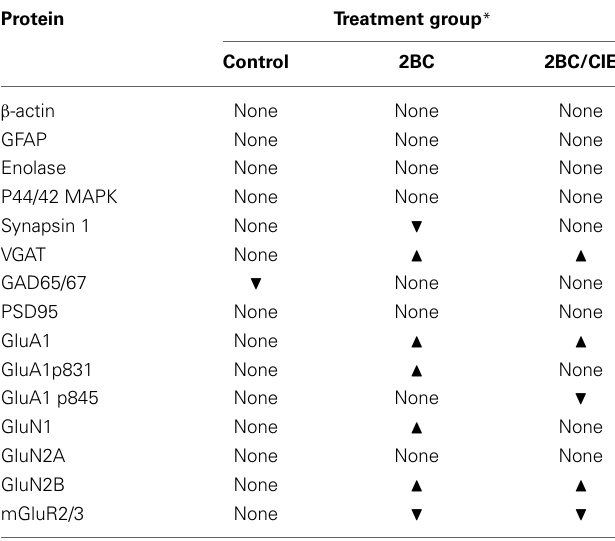
Table 1 | CCL2 and CCL2-ethanol interactions affecting hippocampal protein